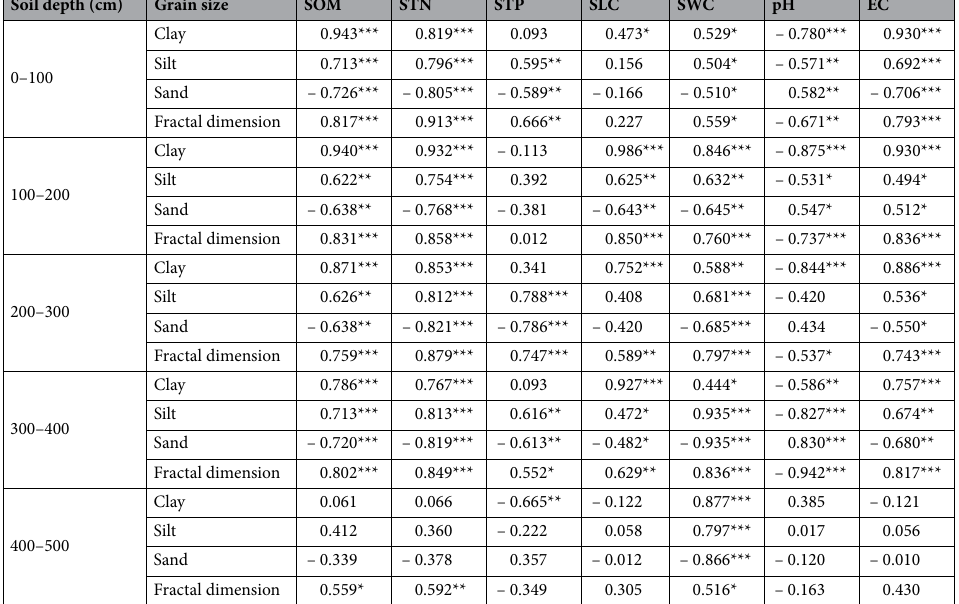
Table 2. Correlations among the fractal dimension, clay, silt, and sand contents and selected soil properties at different soil depths. SOM soil organic matter, STN soil total nitrogen, STP soil total phosphorus, SLC soil